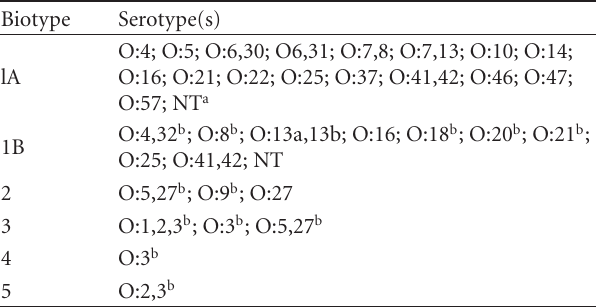
Table 2: Relatioship between biotype, O serotype and pYV carriage of Y. enterocolitica (adapted from